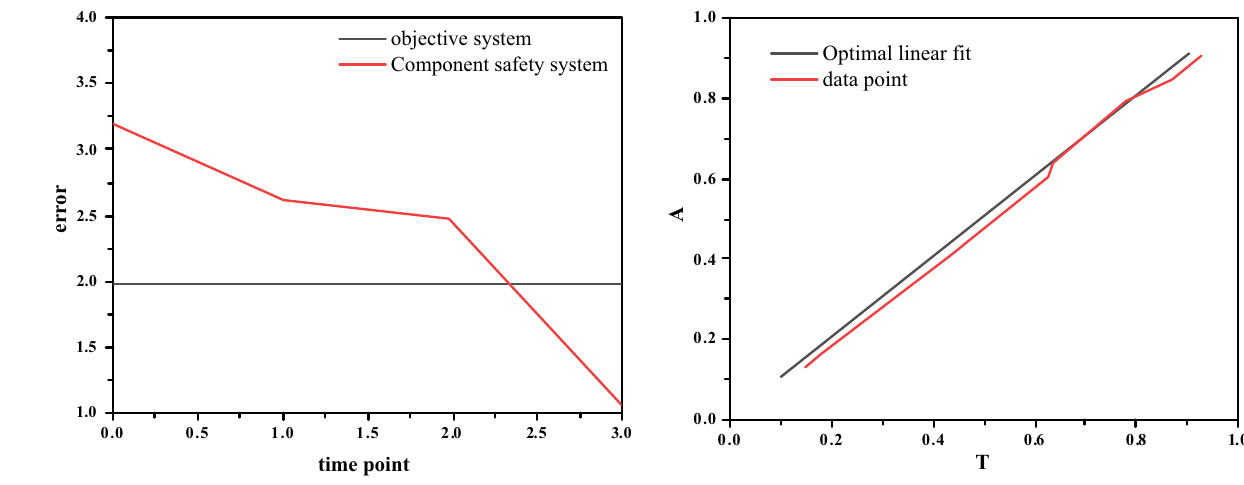
Figure 3: Computer network error rate. Figure 4: Fitting curve obtained by using nonlinear regression method to process the data of computer network security